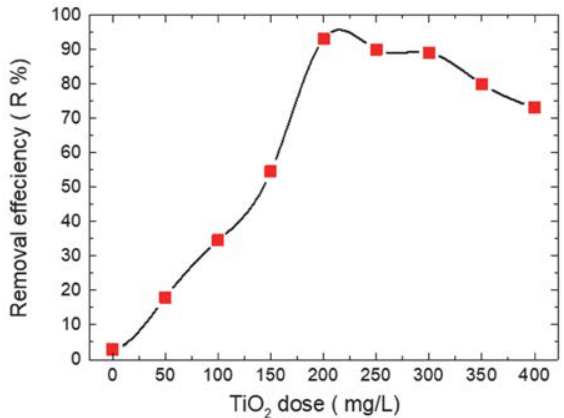
Figure 3: Removal rate of imazapyr under variation of TiO 2 concen- tration. C(Imazapyr) = 5 μΜ; stirring speed = 1000 min –1 , aqueous suspension 1 : 3 acetone/ Milli-Q water.